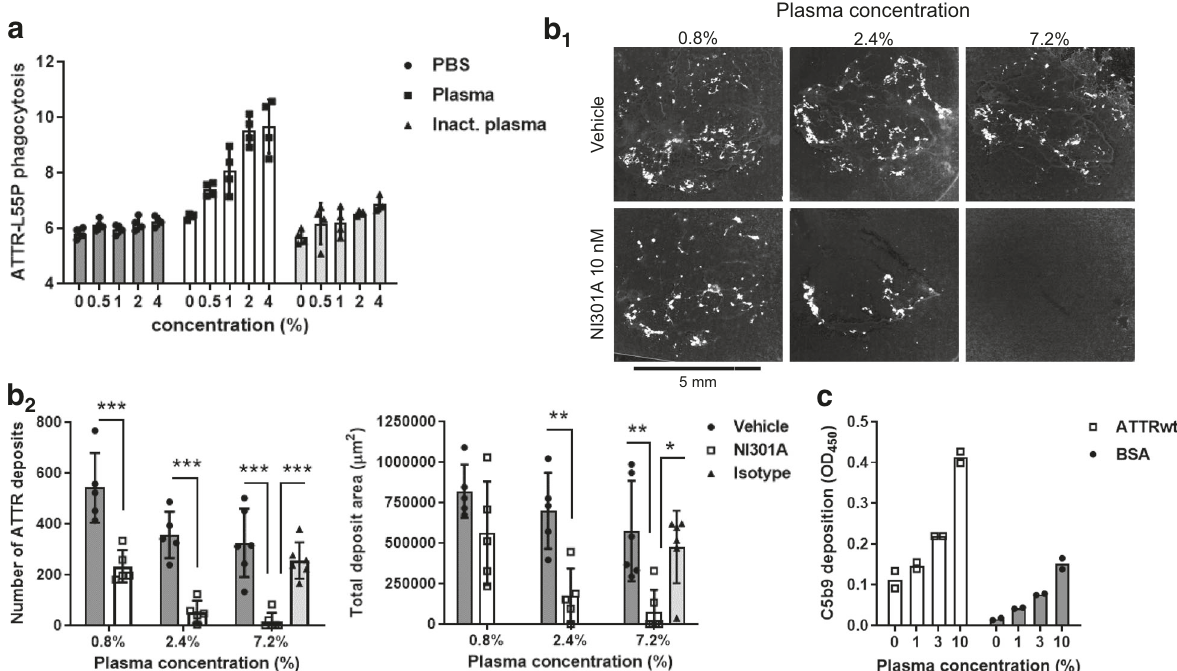
Fig. 5 Antibody-mediated complement activation increases ATTR phagocytosis and tissue amyloid clearance. a In vitro ATTR phagocytosis assay performed with human-derived macrophages, TTR-L55P-atto488, and NI301A in the presence of fresh or heat-inactivated human plasma at different concentrations (mean ± SD of quadruplicates). b Ex vivo tissue amyloid-removal assay performed with three concentrations of fresh human plasma. b 1 Representative pairs of adjacent tissue sections treated with NI301A or vehicle. b 2 Quanti fi cation of number and area of amyloid deposits per tissue section. n = 5 – 6 sections per condition (mean ± SD). Two-way ANOVA for main factors Plasma concentration and Antibody, and Bonferroni ’ s multiple comparisons test of NI301A to vehicle conditions (mean difference and 95% CI). For the number of ATTR deposits: Plasma concentration: F (2,26) = 16.04, P < 0.0001; Antibody: F (1,26) = 84.53, P < 0.0001; NI301A vs. Vehicle using 0.8% plasma: − 309.4 ( − 461.5 to − 157.3), *** P < 0.0001; NI301A vs. Vehicle using 2.4% plasma: − 302.6 ( − 454.7 to − 150.5), *** P < 0.0001; NI301A vs. Vehicle using 7.2% plasma: − 308 ( − 446.9 to − 169.1), *** P < 0.0001;